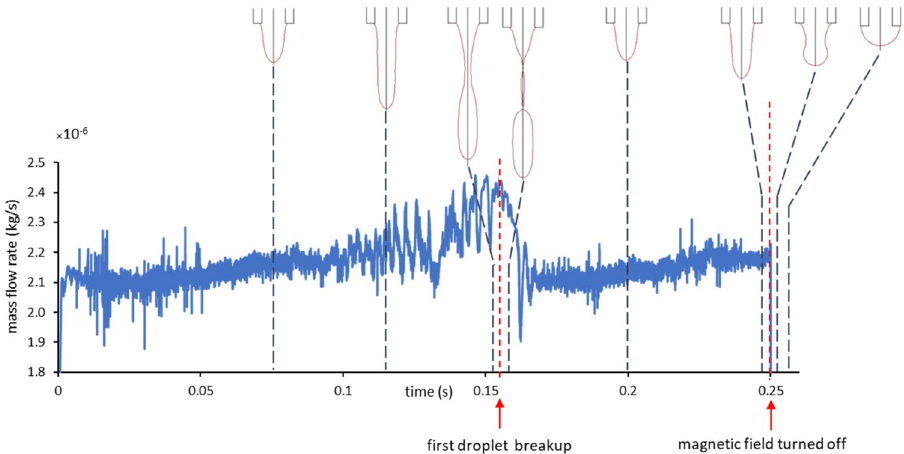
Figure 9. Mass flow rate of ferrofluid from the nozzle versus time showing DoD feature when the magnetic field is turned off at 0.25 s.